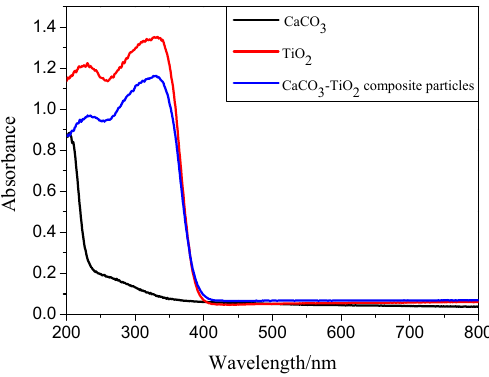
Figure 6. UV-vis absorption spectra of CaCO 3 , TiO 2 , and CaCO 3 -TiO 2 composite particles.